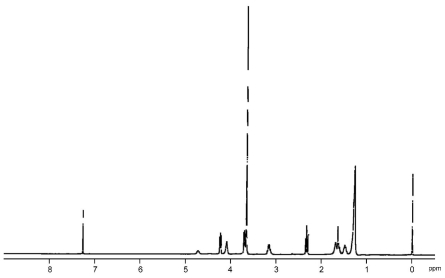
1H NMR spectrum of CEEU(6) in DMSO-d6.